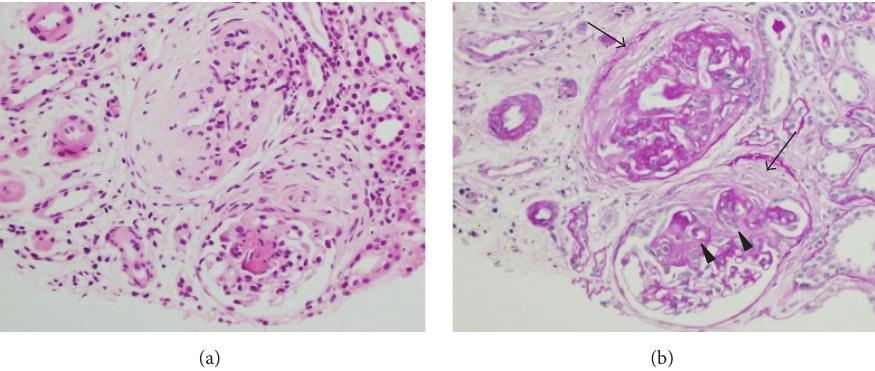
Figure 2: Pathological findings of the renal biopsy specimen. Cellular crescent formations (arrow) and lobulation were observed in the glomeruli (arrowhead) by (a) Haematoxylin and Eosin stain ( × 400) and (b) Periodic acid-Schiff stain ( × 400).